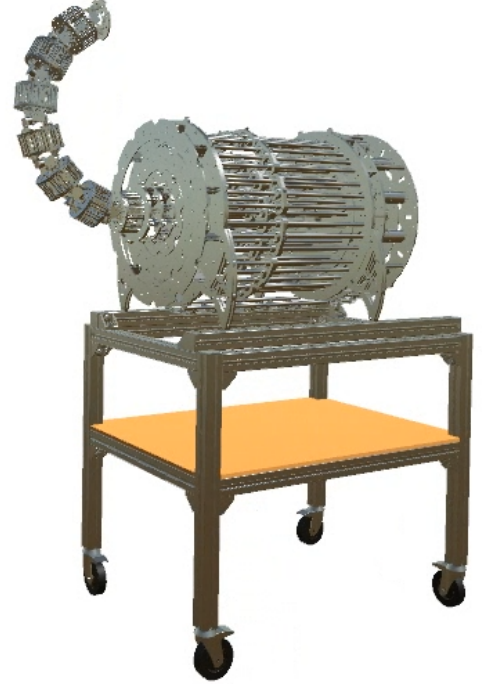
Figure 1. Complete mechanical design of a tendon-driver, discrete and hyper-redundant manipulator with 14 degrees of freedom and 7